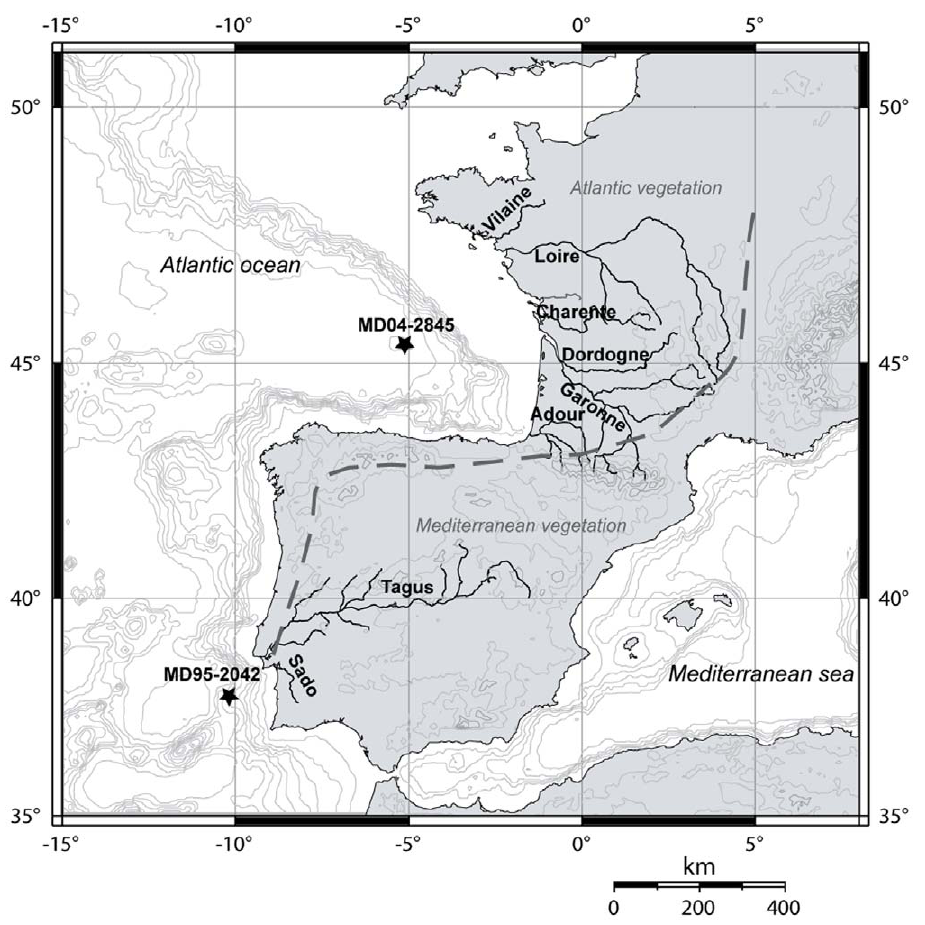
Figure 1. Location of cores MD04-2845 and MD95-2042 (filled stars) and main rivers draining Western France and Southwestern Iberia. Dashed line divides the Atlantic and Mediterranean biogeographical zones [118].